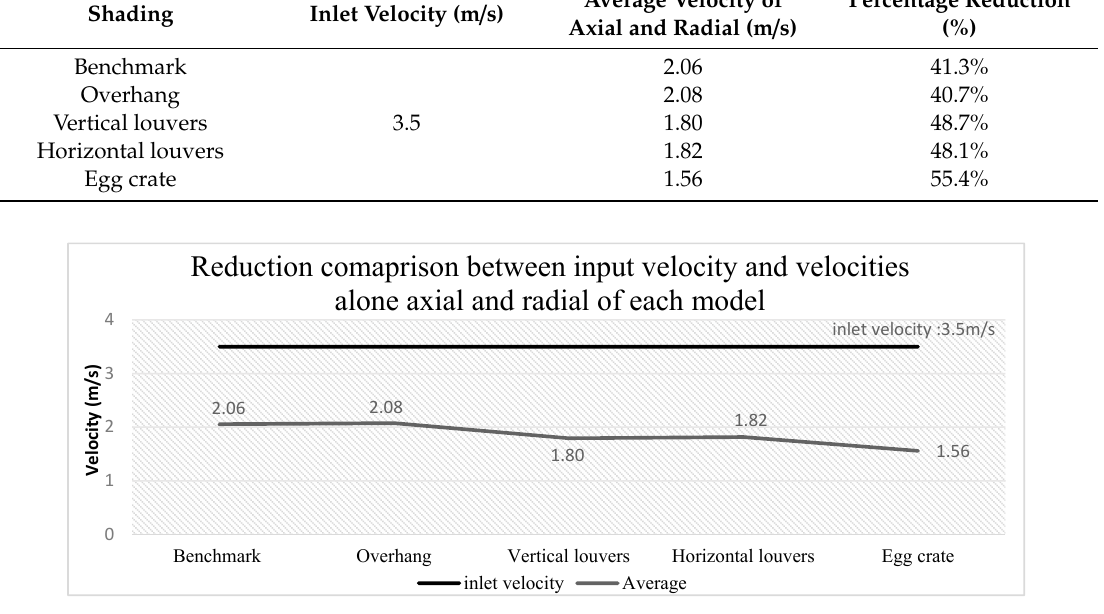
Table 16. Average velocity of axial and radial for each model.